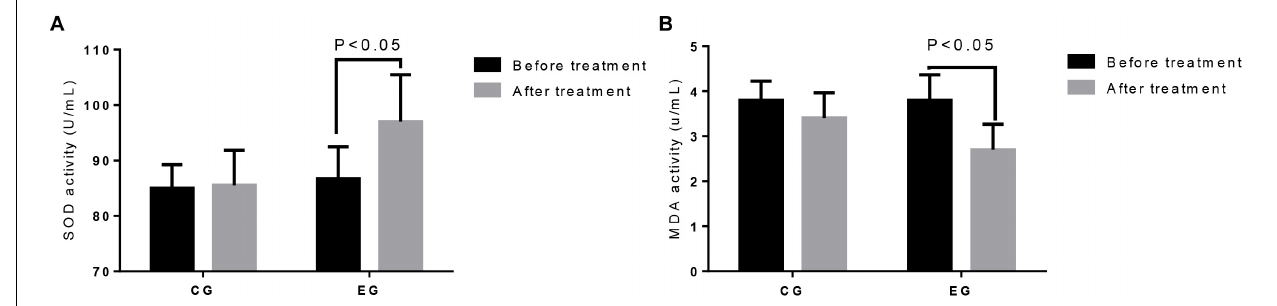
FIGURE 2 | The comparison of antioxidant activities between two groups. (A) SOD activity. (B) MAD activity. The statistical difference was significant if p < 0.05 vs. the control group.